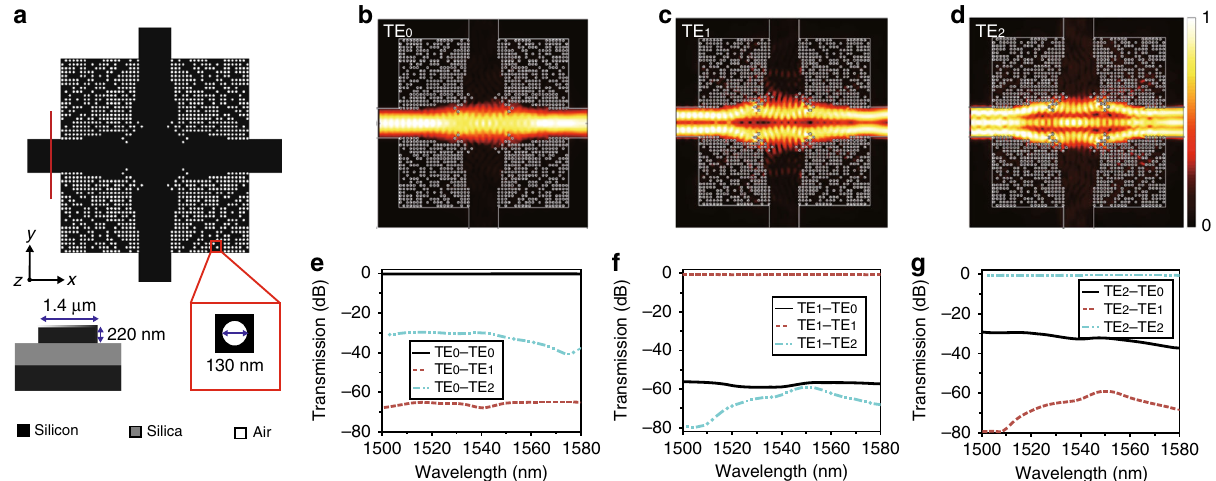
Fig. 3 Design and simulation results of the three-mode crossing. a Schematic diagram of the designed three-mode crossing with digital meta-structure. b ‒ d The simulated optical fi eld distributions for the three-mode crossing with TE 0 ‒ TE 2 . e ‒ g The simulated transmission spectra for the three-mode crossing with TE 0 ‒ TE 2